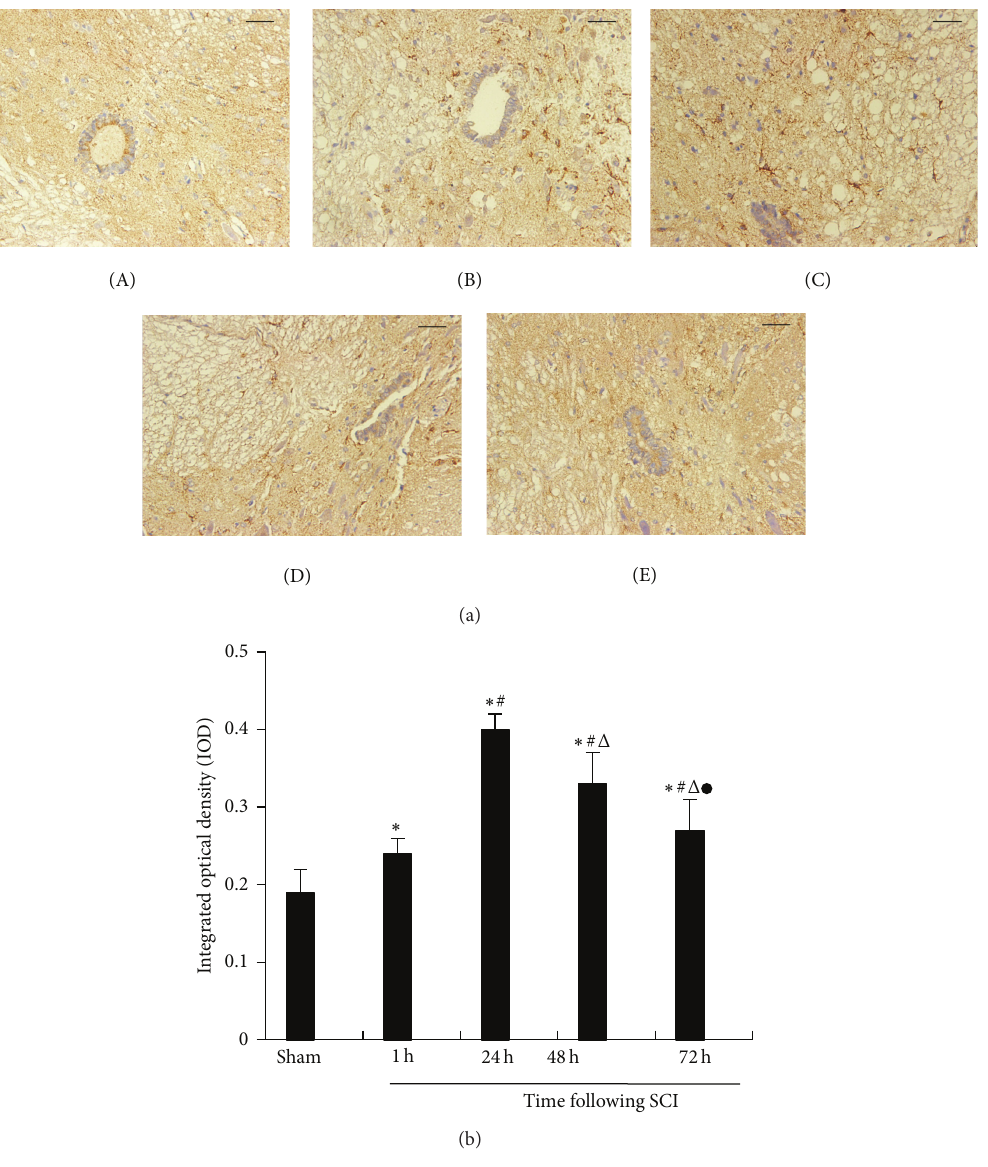
Figure 2: (a) Representative IL-17 immunohistochemistry images in spinal cord tissue (brown granules, original magnification × 400). The sham-operated groups (A) and SCI group at 1h (B), 24 h (C), 48 h (D), and 72 h (E). A digitized image shows labeled IL-17 immunohistochemistry in tissue. The gray value of the IL-17 immunohistochemical expression was assessed. IL-17 expression significantly increased in the rat SCI model group and peaked at 24 h. Bar equals 50 𝜇 m. (b) Morphometric quantitate of IL-17 protein expression in spinal cord tissues. The IOD in different groups was 0.19 ± 0.03 , 0.24 ± 0.02 , 0.40 ± 0.02 , 0.33 ± 0.04 , and 0.27 ± 0.04 , respectively. Representative spinal cord tissue sections from the sham-operated group ( 𝑛 = 15 ) and SCI groups at 1h ( 𝑛 = 15 ), 24 h ( 𝑛 = 15 ), 48 h ( 𝑛 = 15 ), and 72 h ( 𝑛 = 15 ) rats. The data are presented as the mean ± the SE. ∗ 𝑃 < 0.05 versus sham, # 𝑃 < 0.05 versus 1 h, △ 𝑃 < 0.05 versus 24 h, and e 𝑃 < 0.05 versus 48